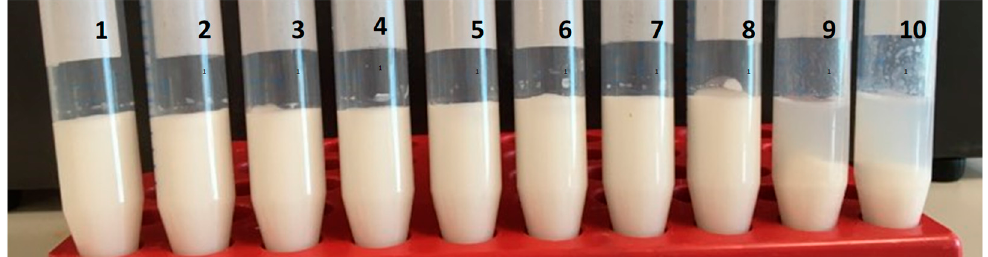
Figure 1. Skimmed UHT milk inoculated with extracellular media from the four Pseudomonas strains and the control after 45 days of storage at 20 °C. From left to right, 1–2: control UHT milk, 3–4: P. fluorescens DSM 50120, 5–6: P. weihenstephanensis DSM 29166, 7–8: P. fluorescens DSM 50090 and 9–10: P. panacis DSM 18529.